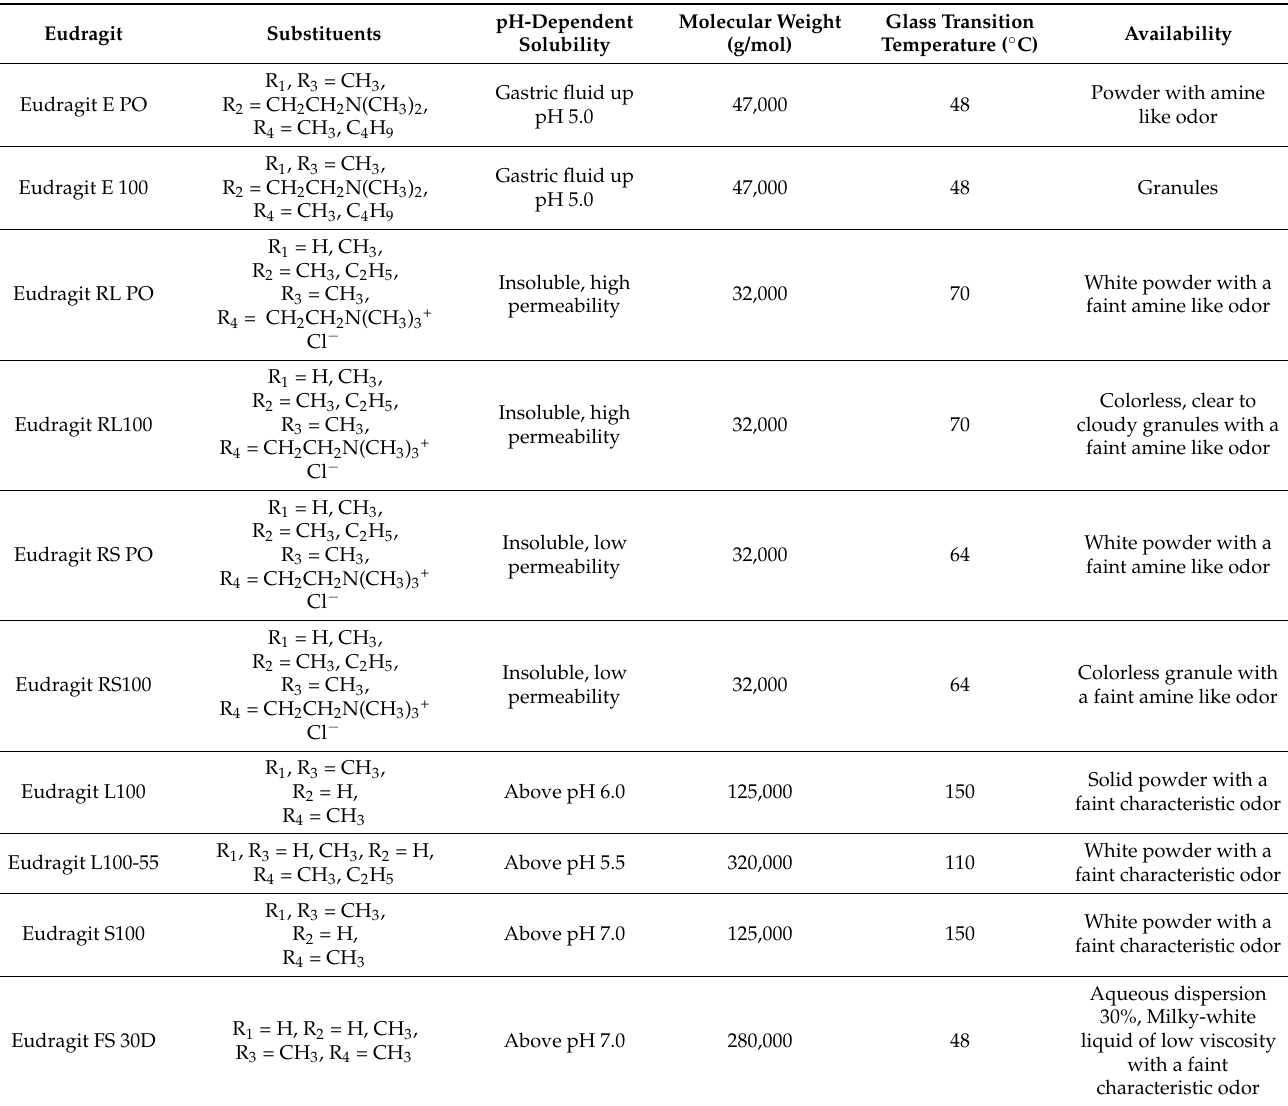
Table 1. Different Eudragit grades, their chemical composition, and physical